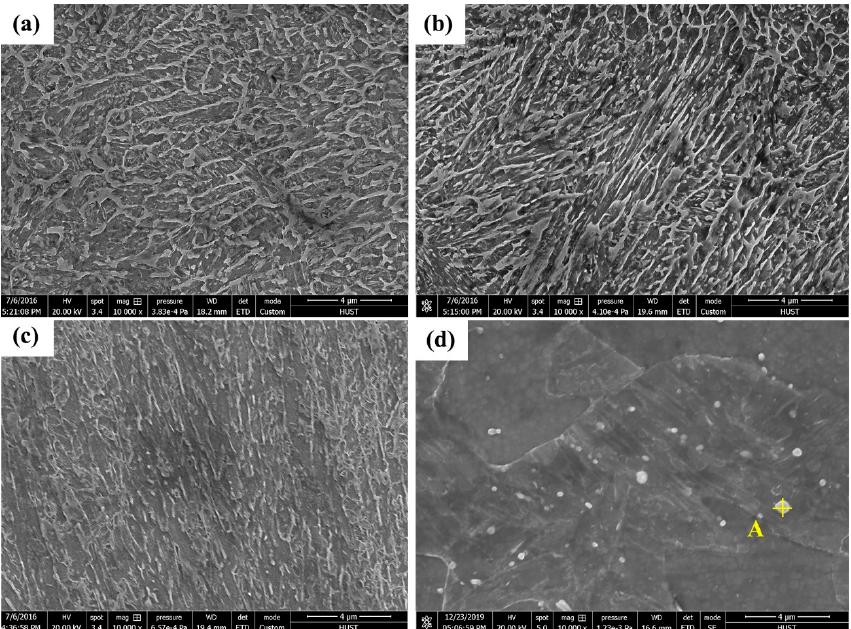
Figure 4. SEM images of the ( a ) As ‐ SLMed part viewed perpendicular to the building direction and ( b ) As ‐ SLMed part viewed horizontal to the building direction; ( c ) T ‐ SLMed part viewed parallel to the building direction; and ( d ) Forged H13 part that before TF tests.